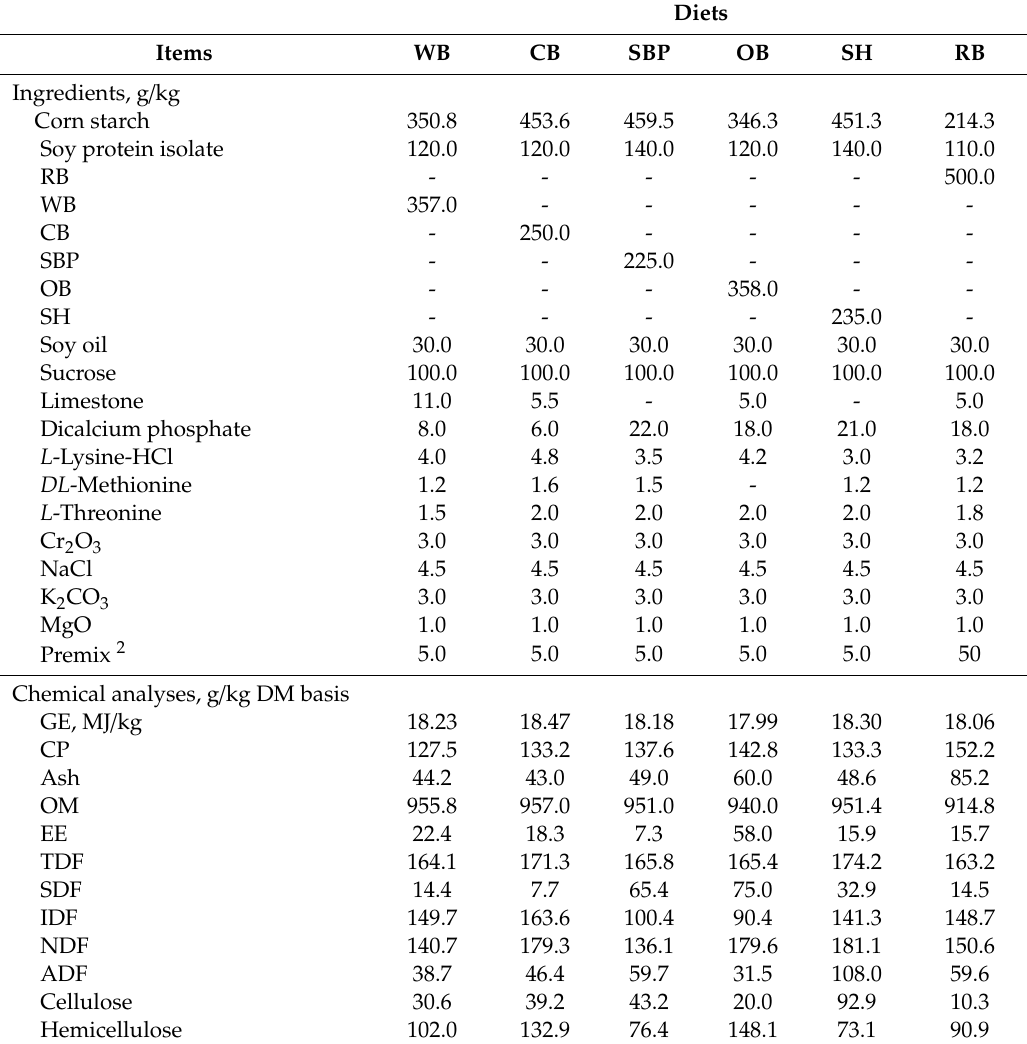
Table 1. The composition of experimental diets 1